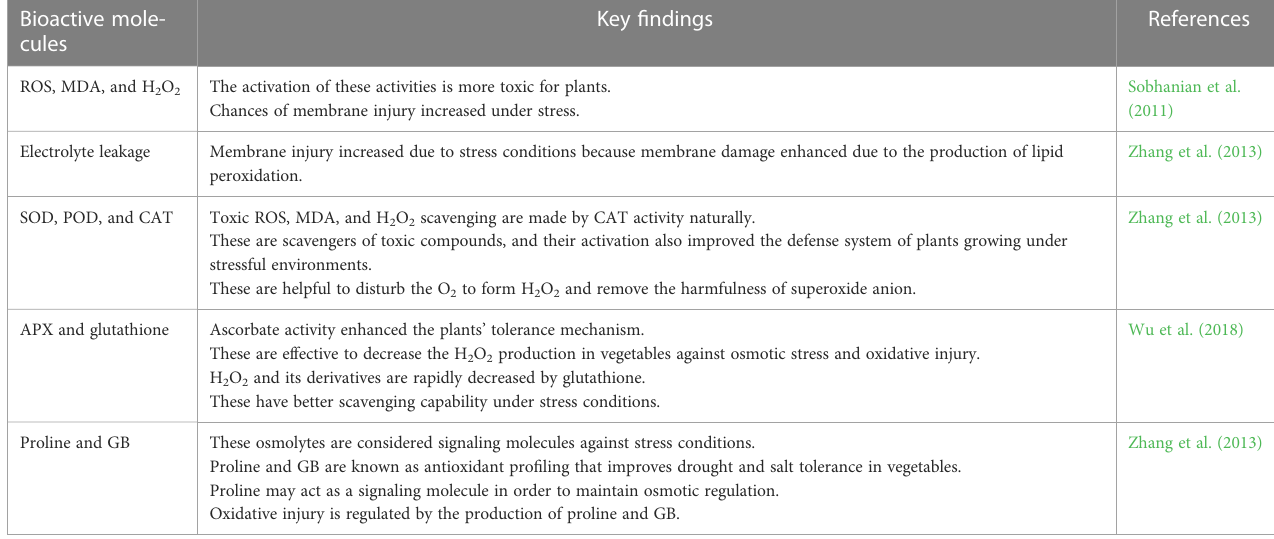
TABLE 1 Role of different antioxidant activities in drought and salt tolerance mechanism of vegetable crops. Bioactive mole-